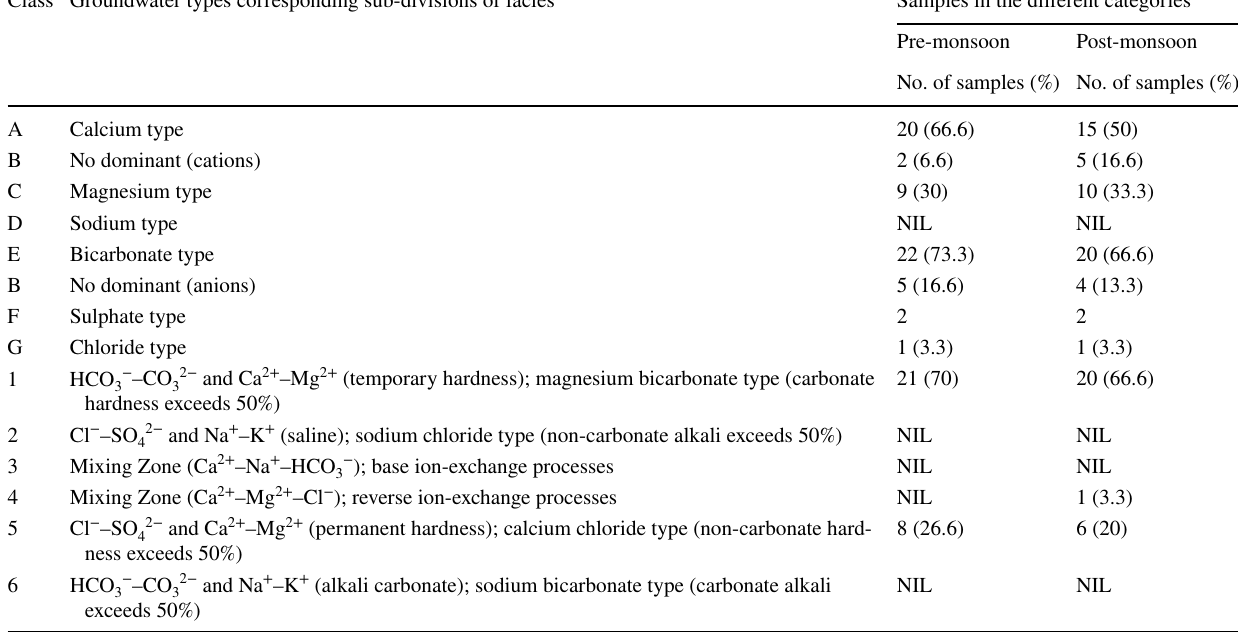
Table 5 Groundwater samples characterization based on Piper diagram Class Groundwater types corresponding sub-divisions of facies